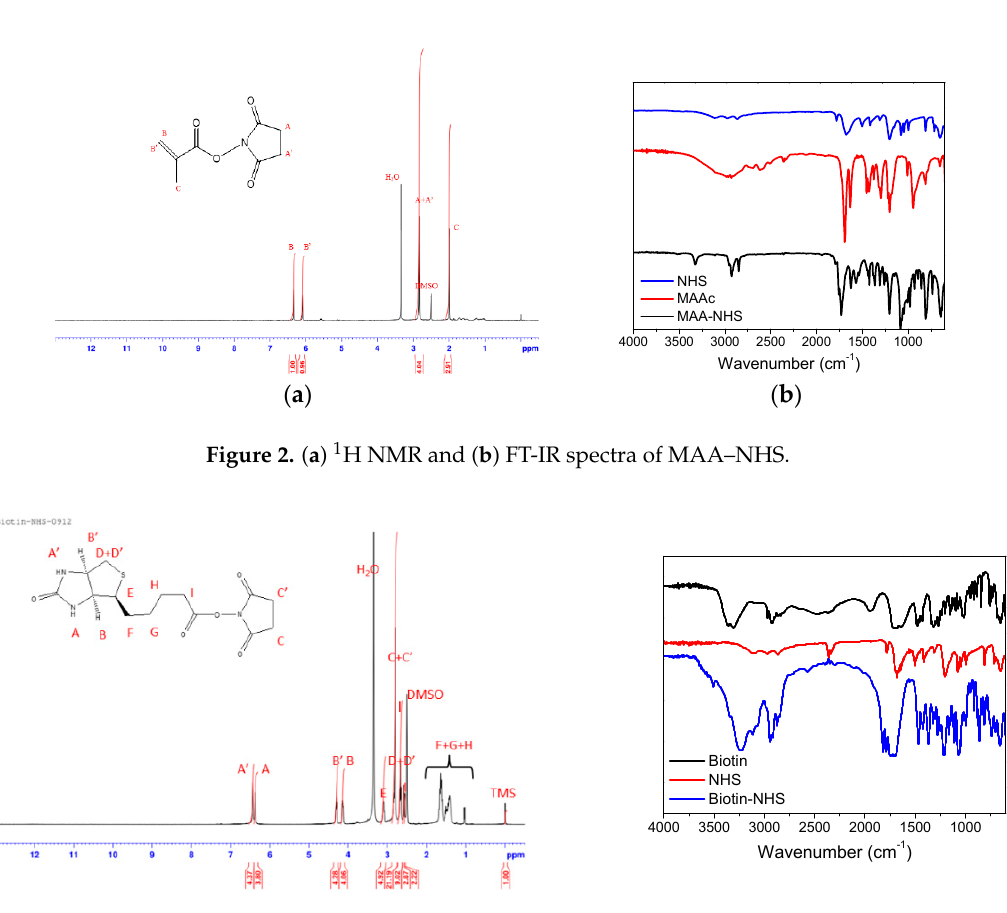
( b ) Figure 5. ( a ) Particle size and ( b ) PDI for of BD and HBD nanoparticles prepared from various copolymer/IMQ feed ratios. To understand the influence of copolymer/IMQ feed ratio on drug loading and surface charges, nanoparticles with the feed ratios of 0.2 and 1 were collected and analyzed. As shown in Table 2, the zeta potentials for all polymeric nanoparticles were about − 27 mV, perhaps because almost 60 mol % of PMAAc in BD and HBD copolymers constructed the nanoparticles and contributed negative charges to the surface of nanoparticles. Otherwise, except for HBD nanoparticles with a copolymer/IMQ feed ratio of 0.2, the loading efficiencies for other nanoparticles were around 1.3 w / w %. Converting the E.E. values, it is expected that a higher copolymer/IMQ feed ratio contributed